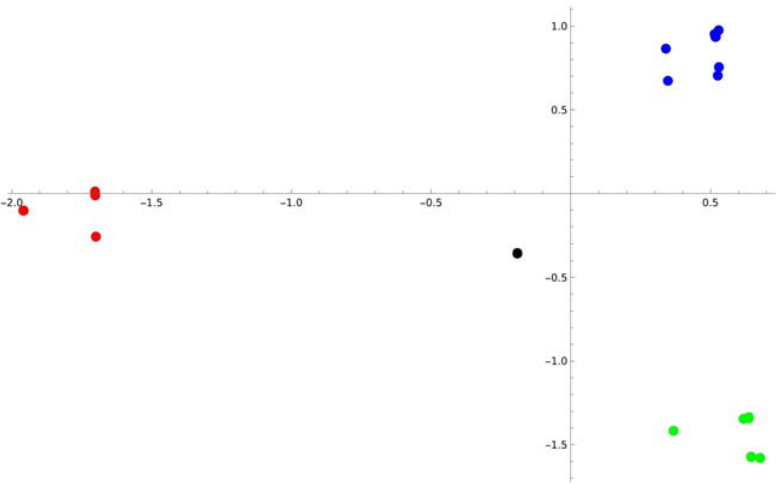
Figure 2: Two - dimensional vertex representatives of the graph of Figure 1. The black point denotes the approximate root of f